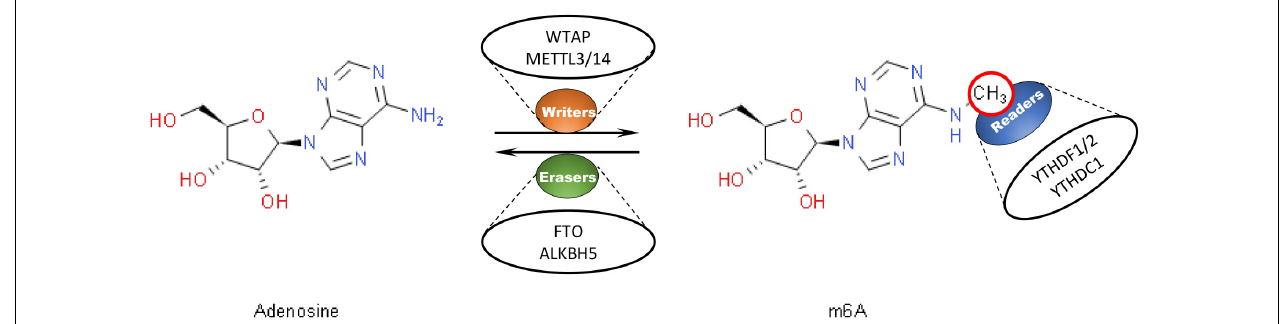
FIGURE 1 | Dynamic and reversible regulation of m6A modification by regulators including “writers,” “readers,” and “erasers.” M6A “writers” serve as methyltransferases, such as WTAP and METTL3/14. M6A “readers” help recognize and bind to m6A-modified transcripts, like YTHDF1/2 and YTHDC1. M6A “erasers” have the ability for demethylation, such as FTO and